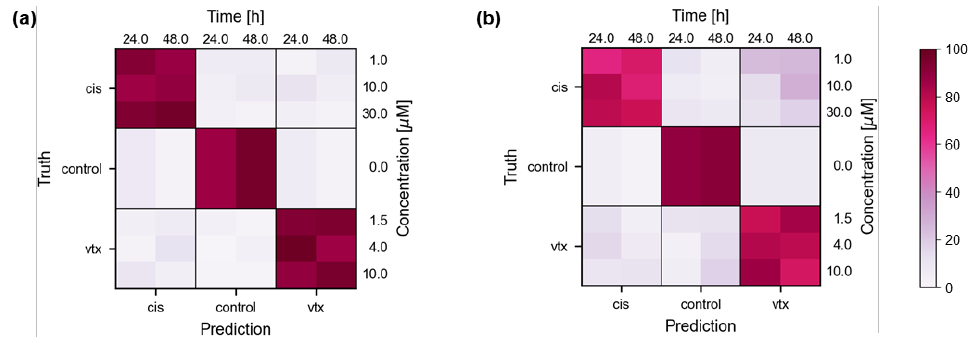
Figure 5. Confusion matrices for the BCO nuclei dataset resolved by drug concentration and exposure time. Classification accuracy (%) with features retrieved from FeaSel-Net ( a ) or PCA loadings ( b ) are shown.